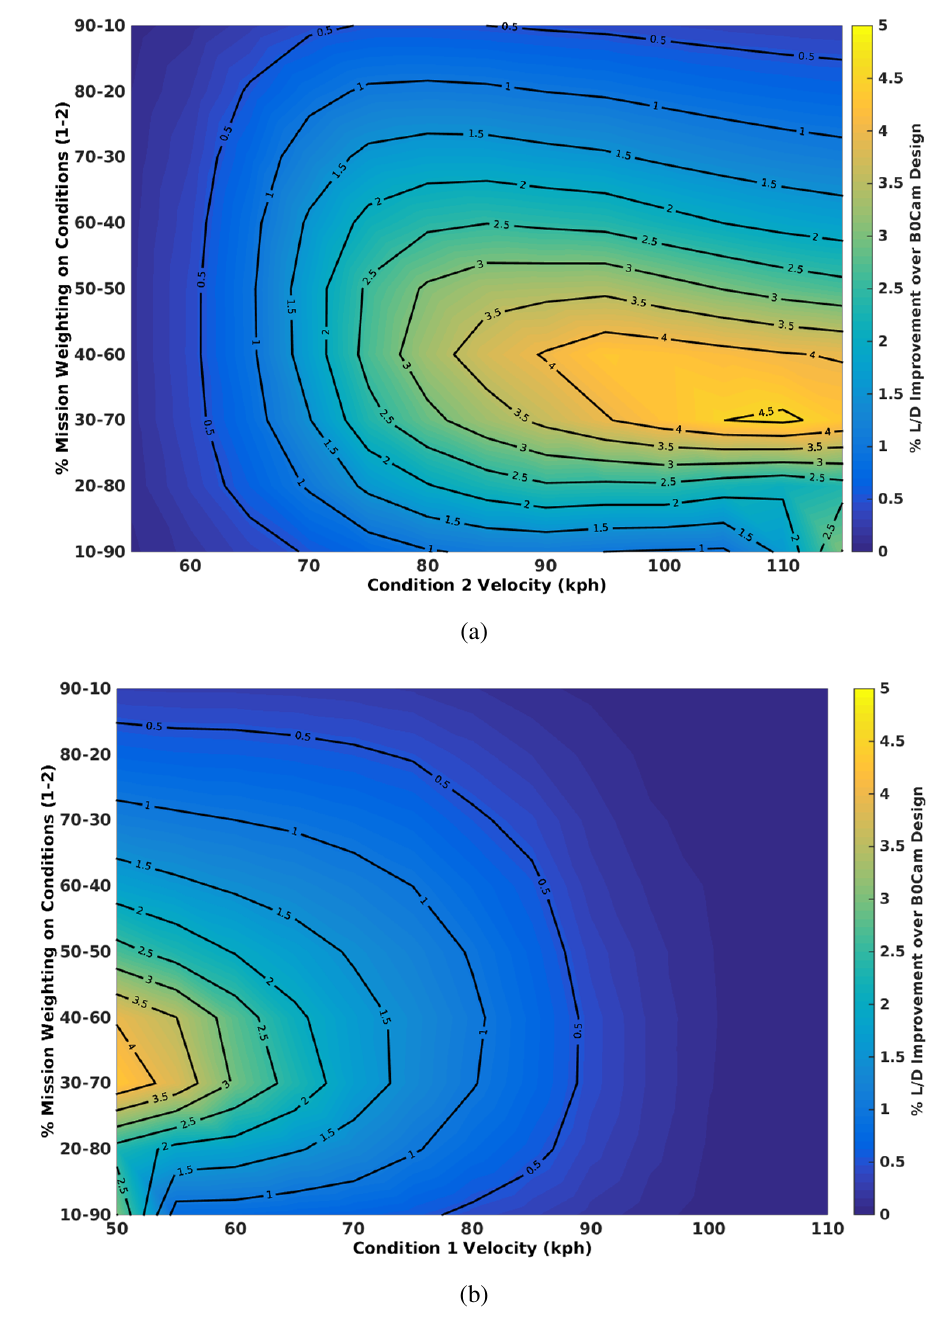
Figure 17. Effect of mission weighting on aerodynamic efficiency for optimum camber morphing design over variable speed ranges normalised to the baseline camber design. ( a ) Aerodynamic efficiency for low speed fixed at 50 kph; ( b ) aerodynamic efficiency for high speed fixed at 115